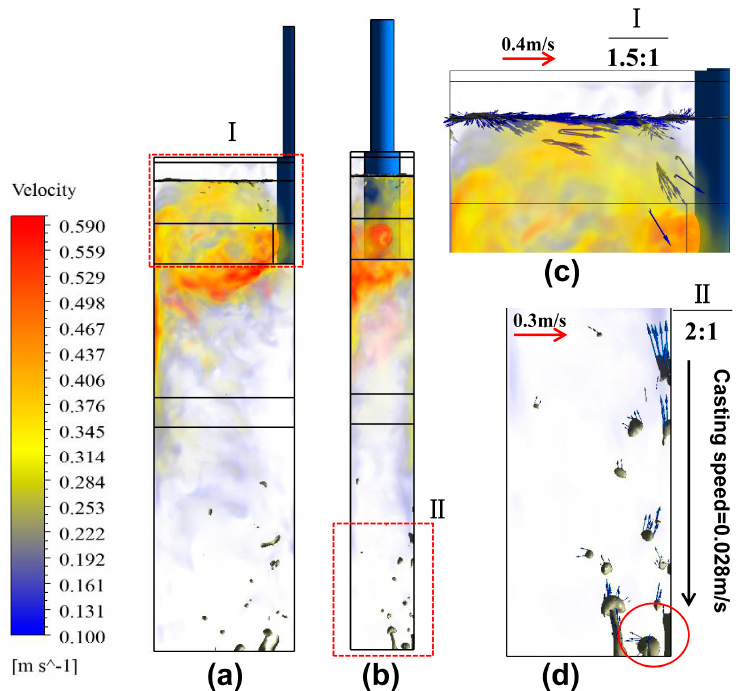
Figure 10. The rendered 3-D flow field with streamlines after ( a ) 1364 s, ( b ) 1796 s, ( c ) 1820 s, ( d ) 2420 s, and ( e ) 3212 s.